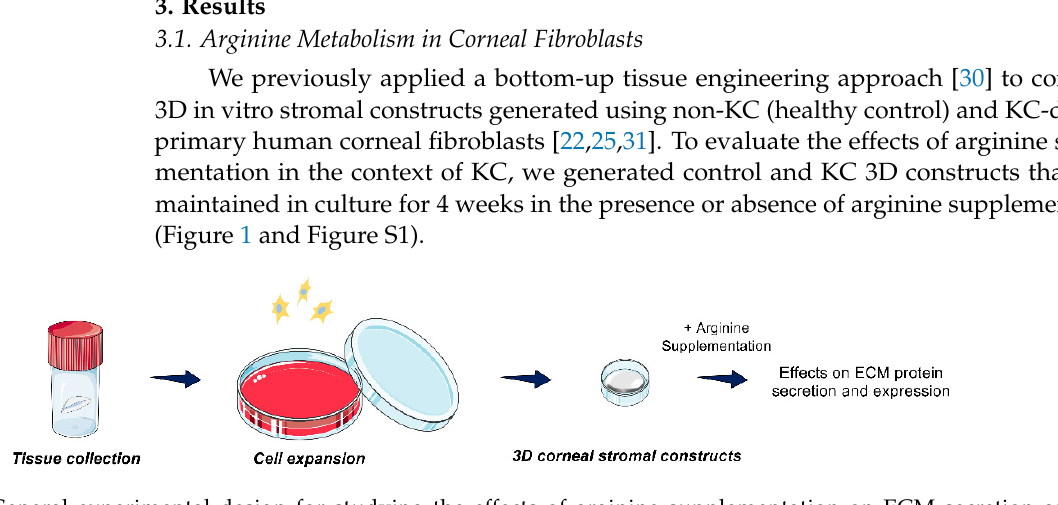
Figure 1. General experimental design for studying the effects of arginine supplementation on ECM secretion and expression by human corneal fibroblasts. The initial step was human corneal tissue collection, corneal fibroblast expansion, and construction of 3D corneal stromal models followed by arginine supplementation. Comparisons between healthy (HCF) and KC-derived (HKC) constructs were performed. Pictorials modified from Servier Medical Art under a Creative Commons Attribution 3.0 Unported